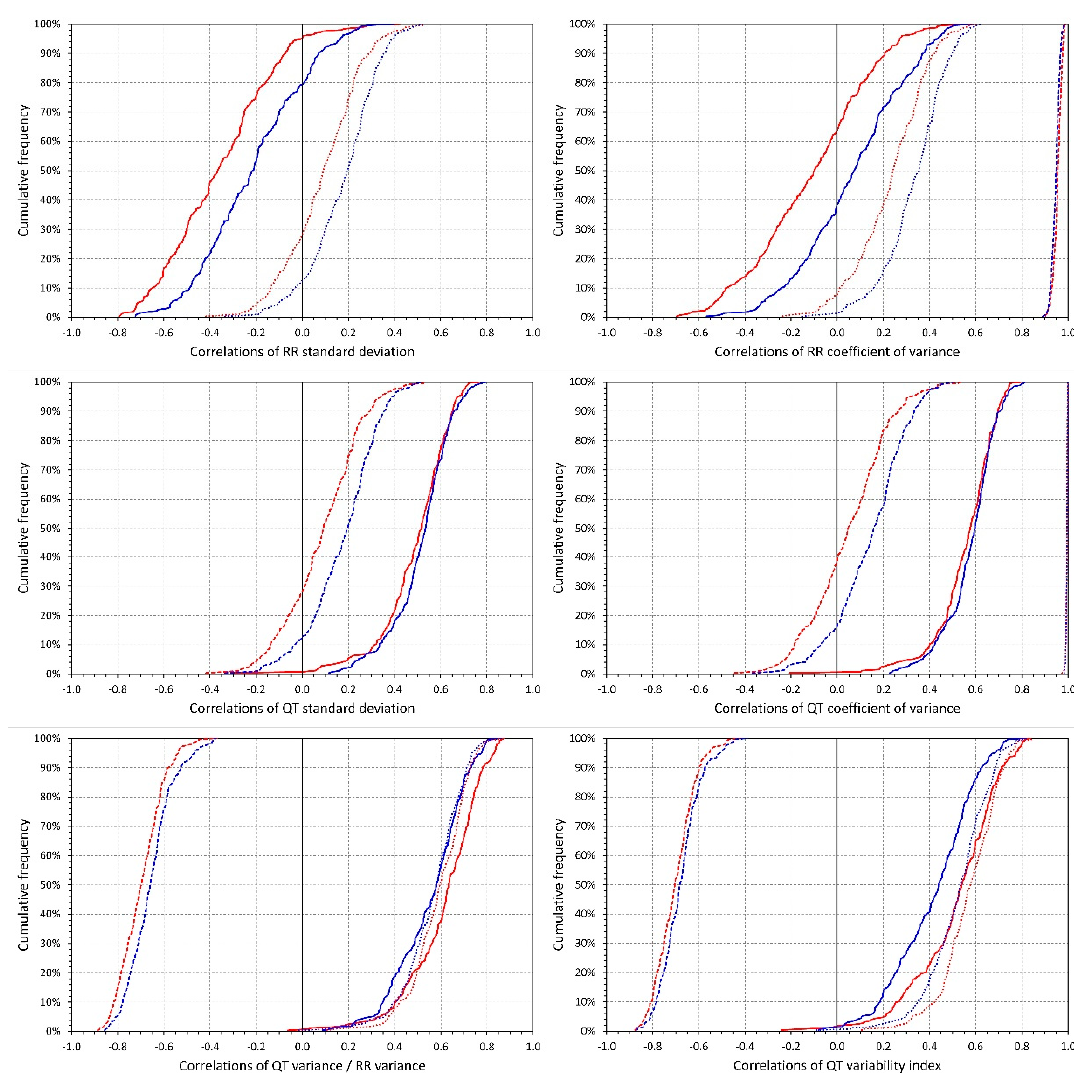
Figure 4. Intra-subject rank correlations. For each of the investigated indices (see the labels of the horizontal axes of individual panels) the figure shows the cumulative distributions of intra-subject Spearman rank correlation coe ffi cients (calculated over all available ECGs in the given subject) between the given index and the underlying heart rate (full lines), standard deviation of RR intervals (dashed line), and standard deviation of QT intervals (dotted line). The red and blue lines correspond to female and male subjects,